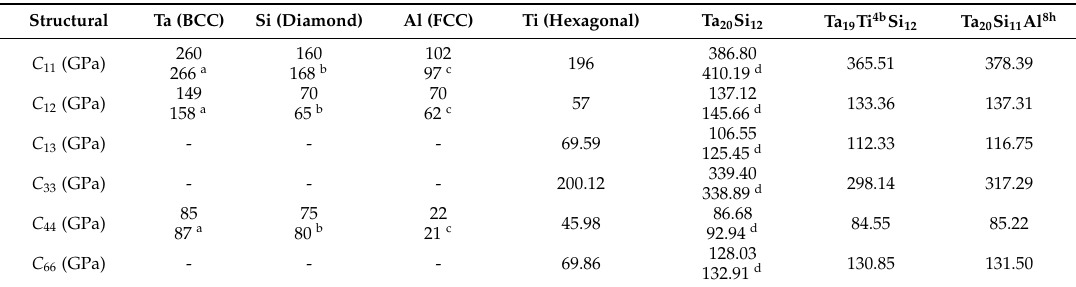
Table 2. Calculated elastic constants for the binary, ternary D8 m -structured Ta 20 Si 12 and their constituent elements compared to the data obtained experimentally and